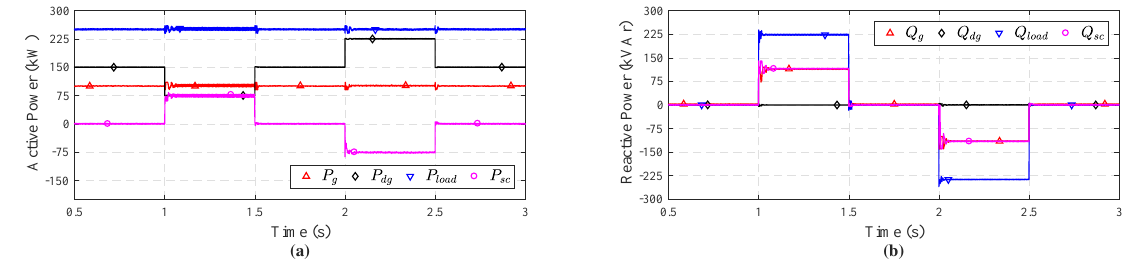
Figure 19. ( a ) Three-phase active powers of the grid, DG, load and smart charger. ( b ) Three-phase reactive powers of the grid, DG, load and smart